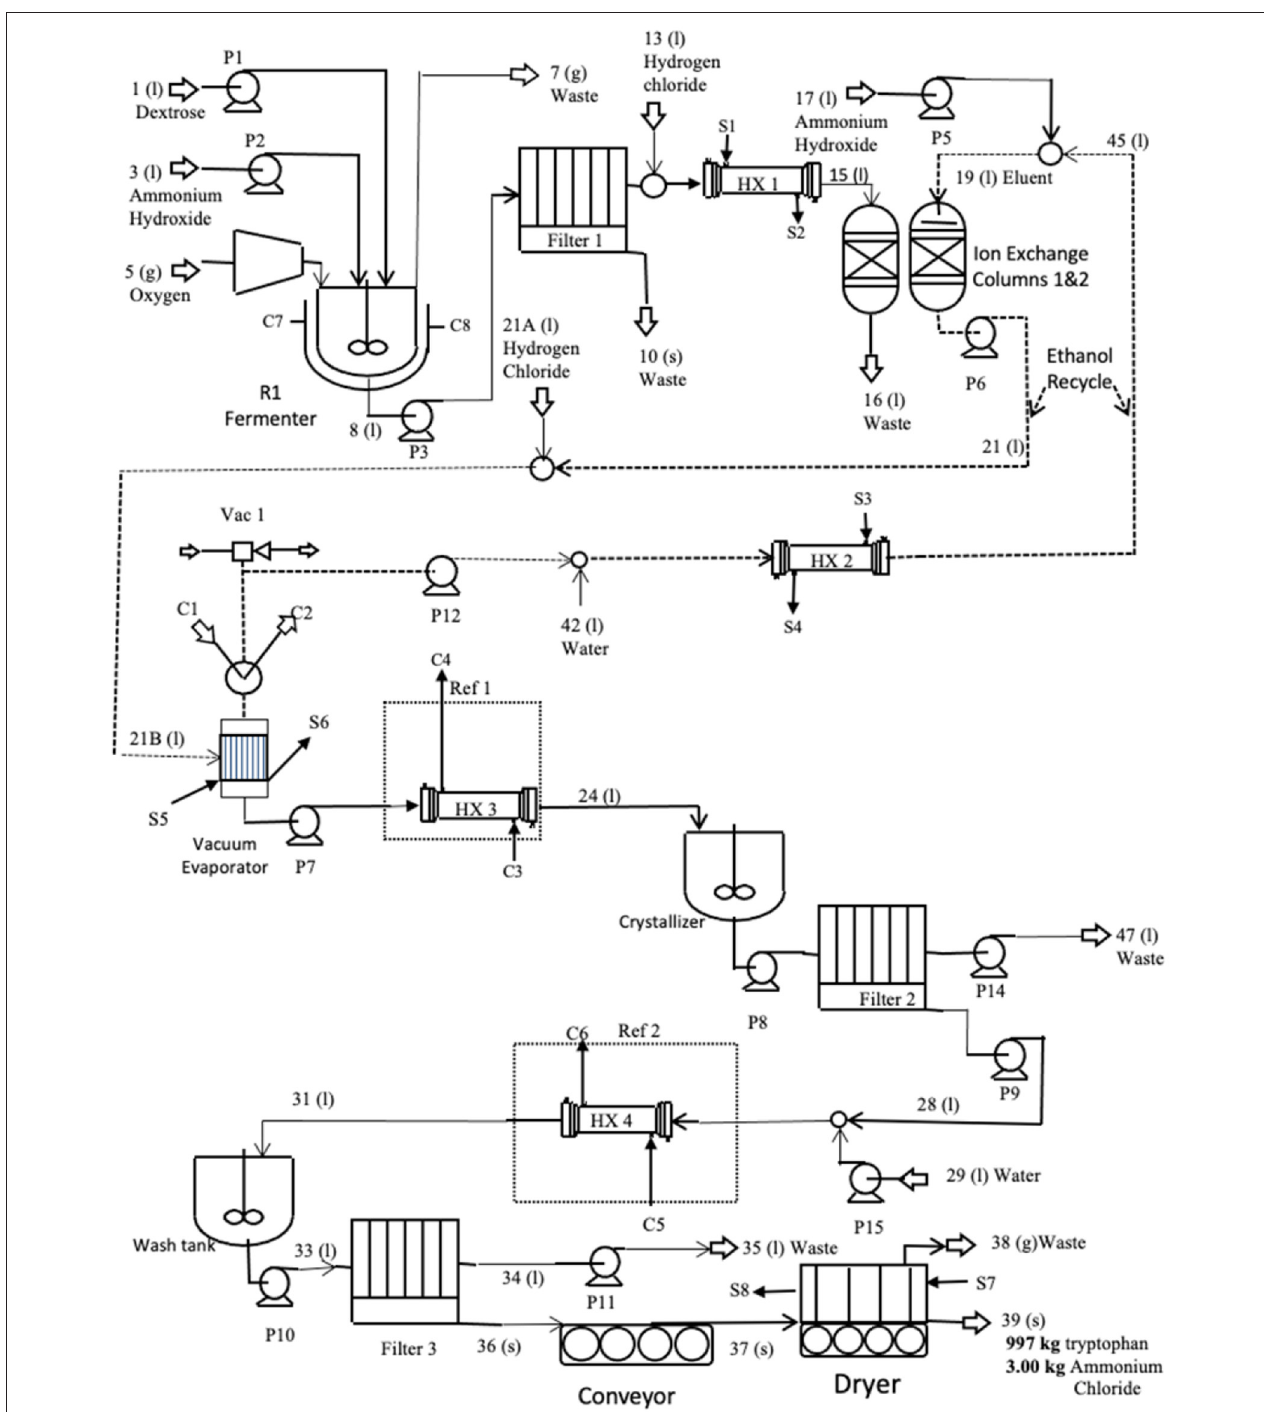
FIGURE 5 | Process schematic of synthesis and purification of L-tryptophan.